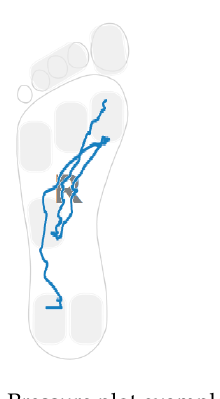
Figure 6. Pressure plot example.